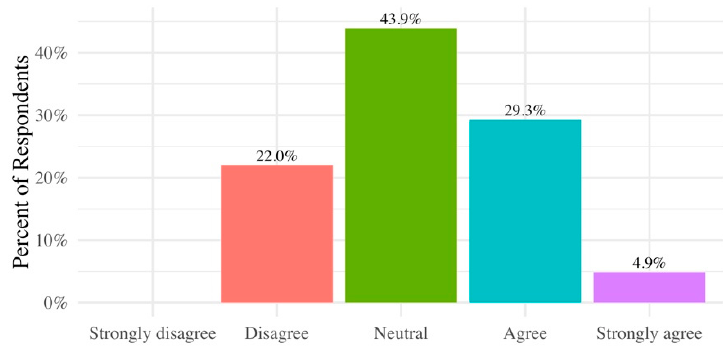
Figure A4. Participants’ perceived risk of heavy metal soil contaminants on health. Total question respondents: 44.